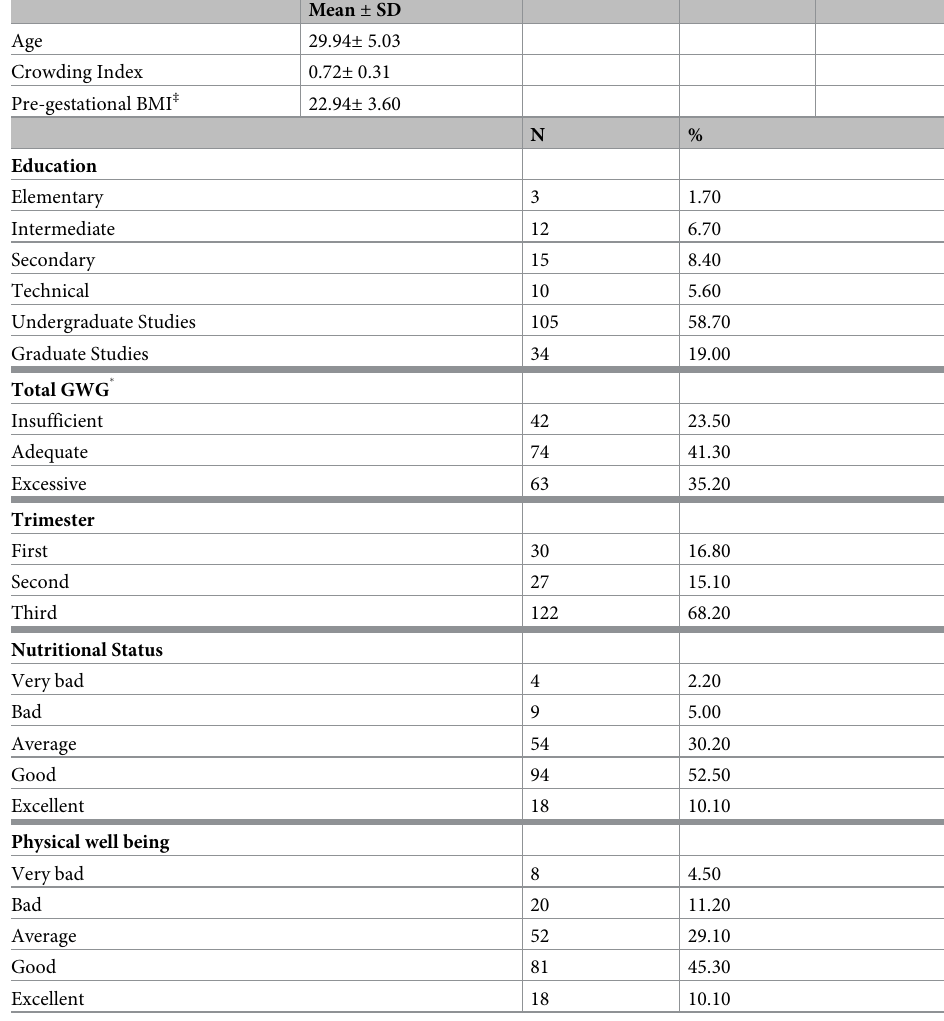
Table 1. Descriptive variables of the sample population (N =